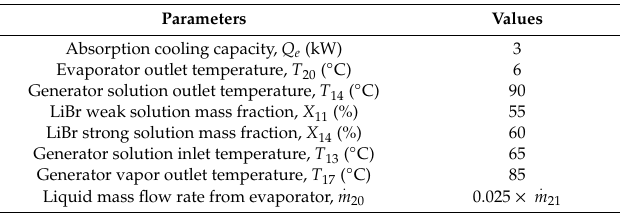
Table 2. Design parameters used in Libr-water absorption